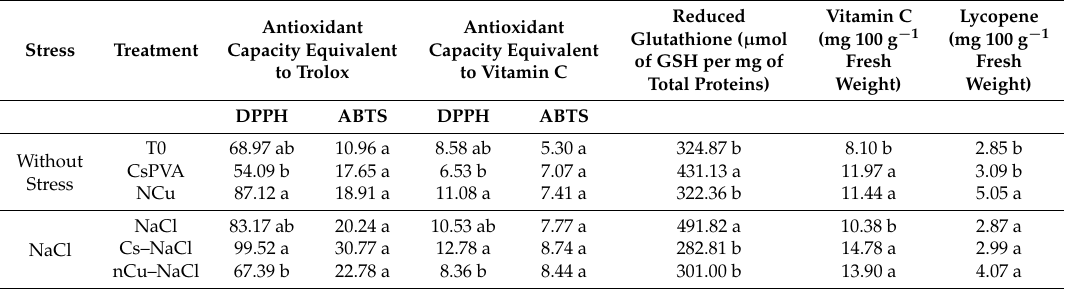
Table 5. Antioxidant capacity in tomato fruits.